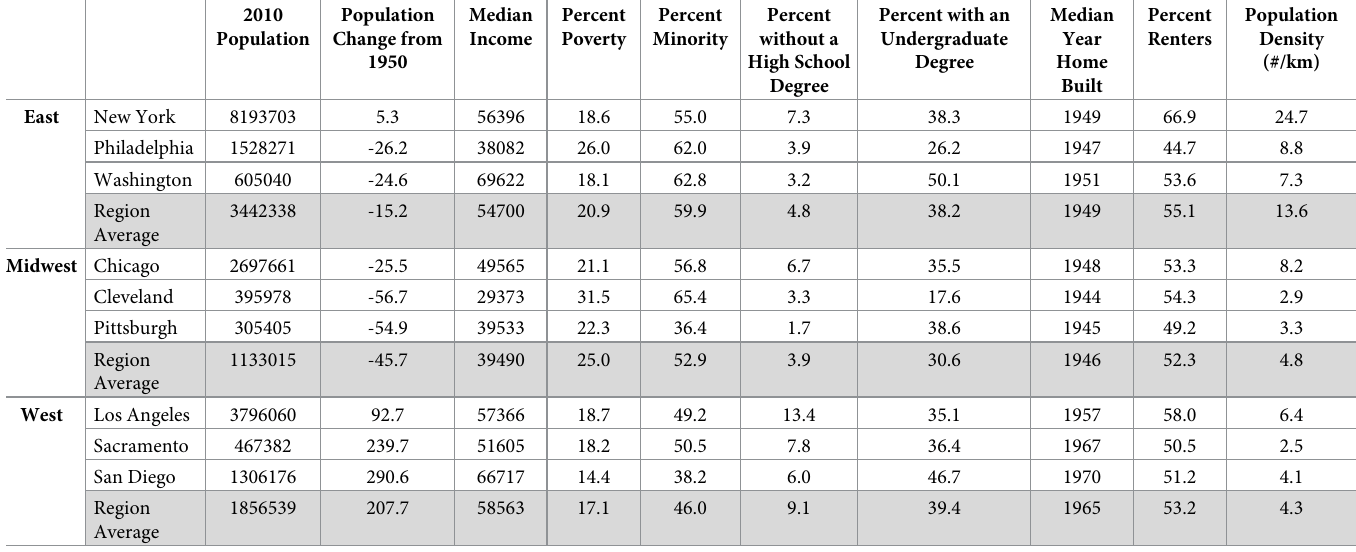
Table 3. Socioeconomic and demographic characteristics of case study cities and regions.